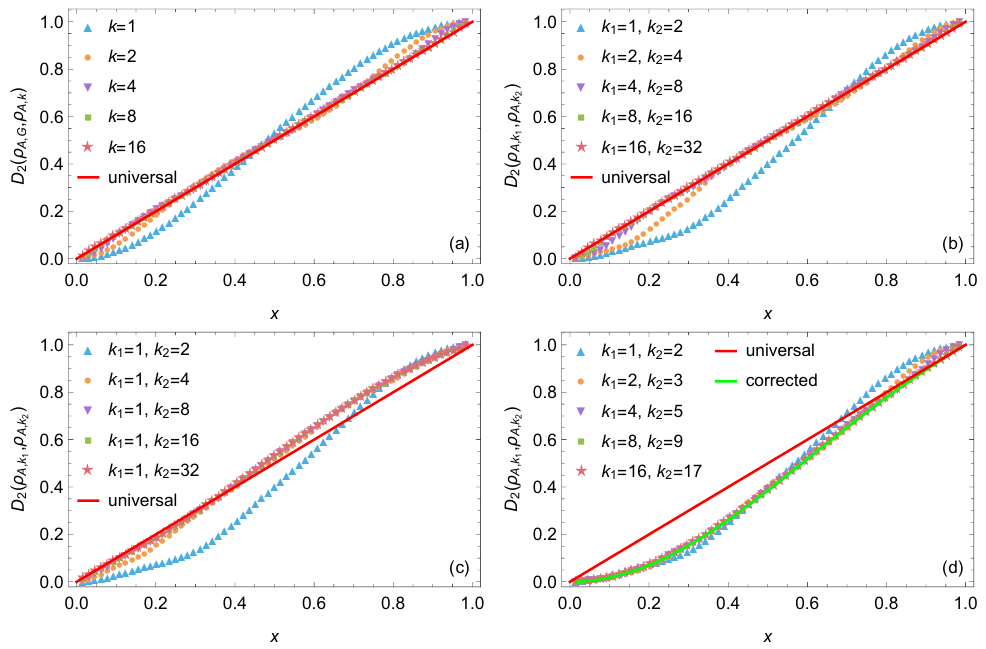
Figure 5 . The numerical results of the second Schatten distance between the ground state and the single-particle states in the massless limit of the harmonic chain (symbols). For comparison, we also plot the universal distance D univ (5.13) (red lines) and the corrected distance D corr 2 (green line). We have set m = 10 − 5 , L = 64